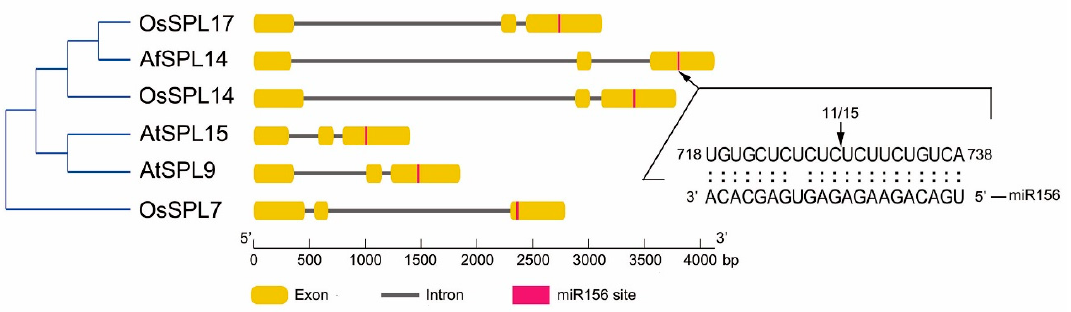
Figure 3. Exon-intron structures of SPL genes in group III from Figure 2 and AfmiR156 cleavage site in AfSPL14 determined by 5 ′ RLM-RACE. For the determination of the AfmiR156 cleavage site in AfSPL14 , 15 clones were selected randomly for sequencing, and 11 of them were cleaved in the position indicated by the arrow towards the base interval of AfSPL14 RNA sequence.